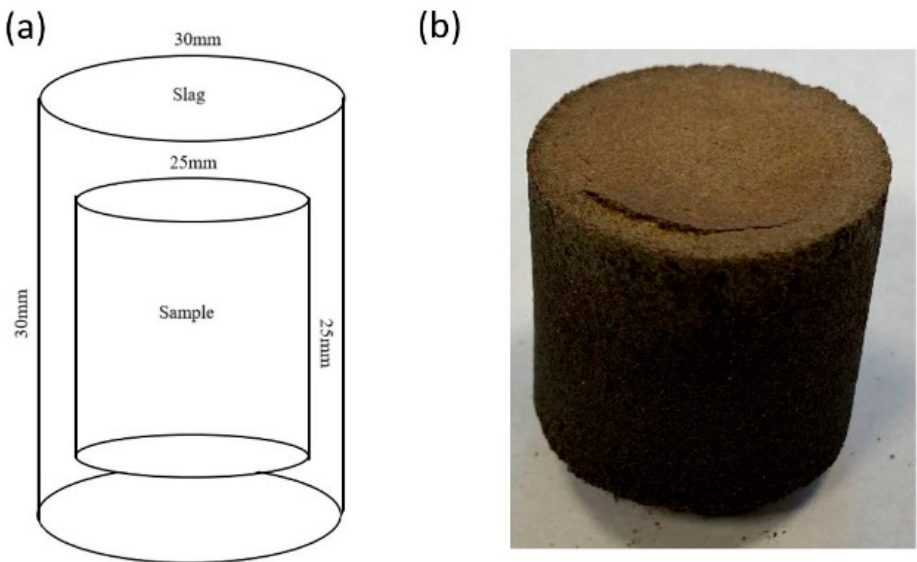
Figure 2. The samples for corrosion testing by the slag-coating method: ( a ) scheme of the corrosion system, ( b ) the commercial refractory sample covered with the shell of slag.